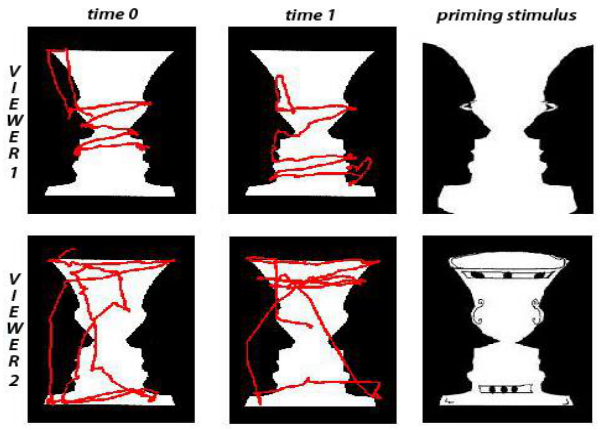
Fig. 1b: ‘Two Faces or a Vase’ (right hand side: priming stimulus) Fig. 1c: Two scanpath sequences at time 0 and 1 (left hand side, viewer 1 upper, viewer 2